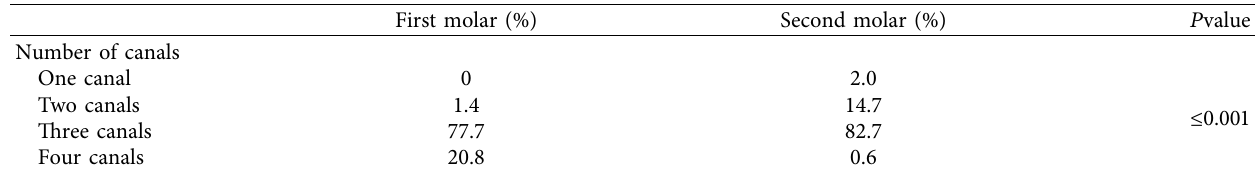
Table 3: Frequency of the numbers of root canals in mandibular molars.